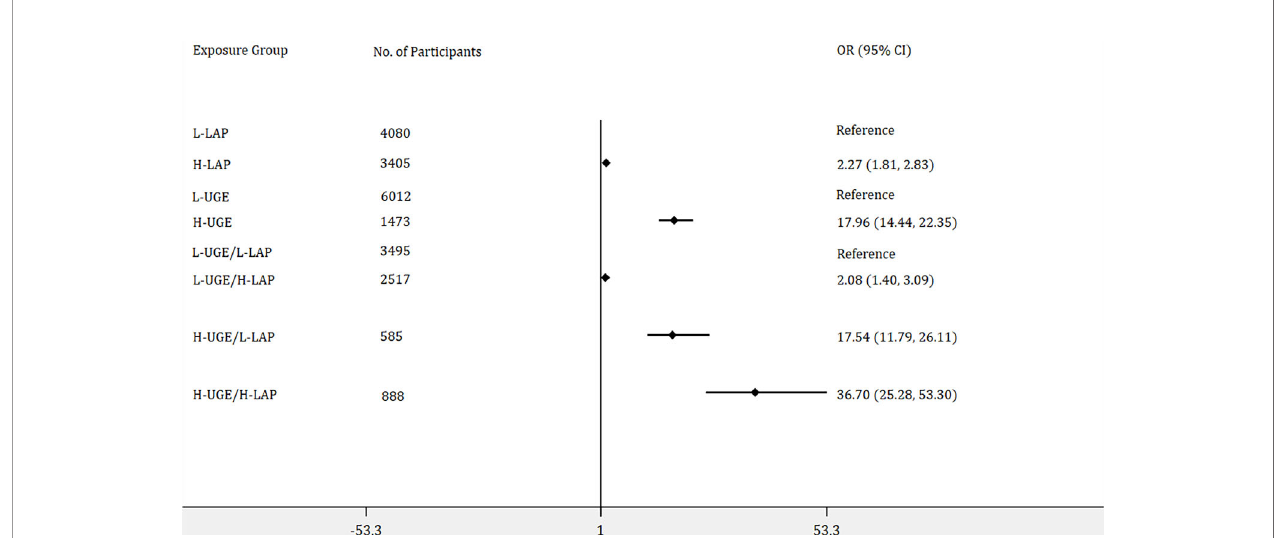
FIGURE 2 | Logistic regression analyses of odds ratios for newly diagnosed diabetes (NDM) with adjustment of age, genders, blood pressure, total cholesterol, body mass index, blood urea nitrogen, and creatinine. The association of lipid accumulation product (LAP) with the risk of NDM was assessed by dividing the participants into two groups: (1) low LAP (L-LAP), (2) high LAP (H-LAP). The L-LAP group was used as a reference in the analysis. The association of urine glucose excretion (UGE) with the risk of NDM was assessed by dividing the participants into low UGE (L-UGE) group and high UGE (H-UGE) group. The L-UGE group was used as a reference in the analysis. In addition, the joint association of UGE and LAP was assessed by dividing the participants into four groups: (1) L-UGE/L-LAP, (2) L-UGE/H-LAP, (3) H-UGE/L-LAP, (4) H-UGE/H-LAP. The L-UGE/L-LAP group was used as a reference in the analysis. The forest plot was displayed in odds ratio and 95% con fi dence